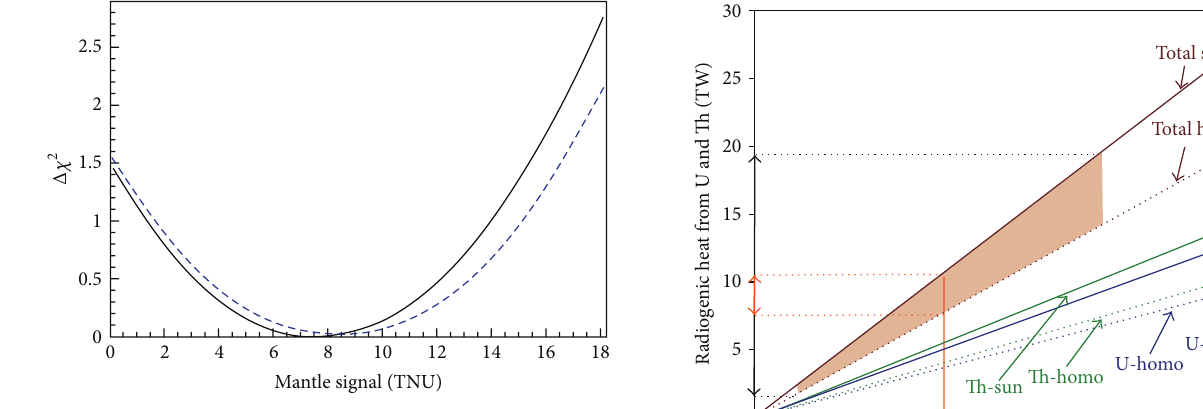
Figure 10: Δ𝜒 2 profile for the mantle signal in the Borexino + KamLAND combined analysis. The black continuous line assumes a spherically symmetric mantle, while the dashed blue line a nonhomogeneous TOMO model from [14].